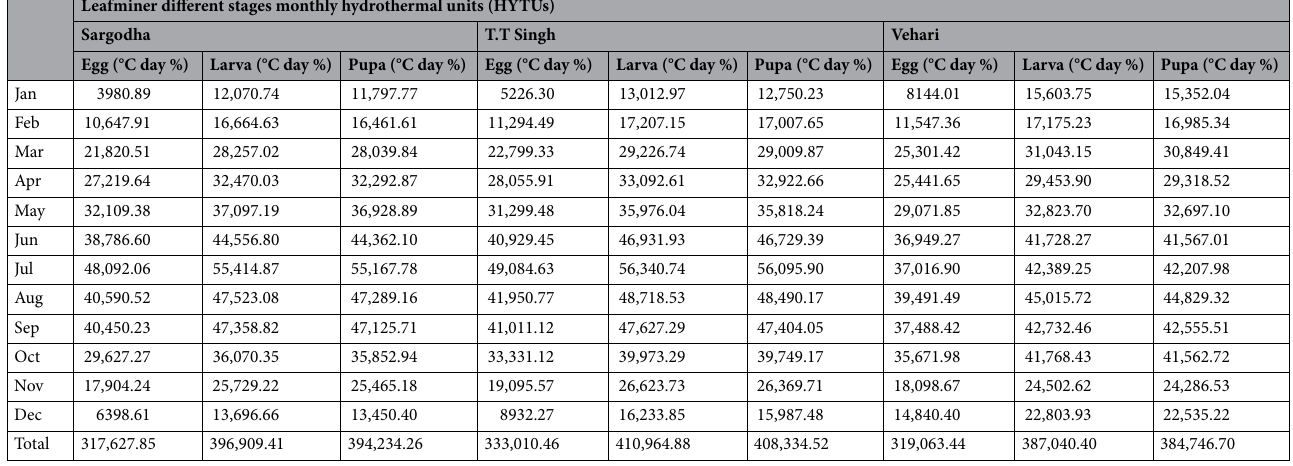
Table 7. Leafminer hydrothermal units (HYTUs).